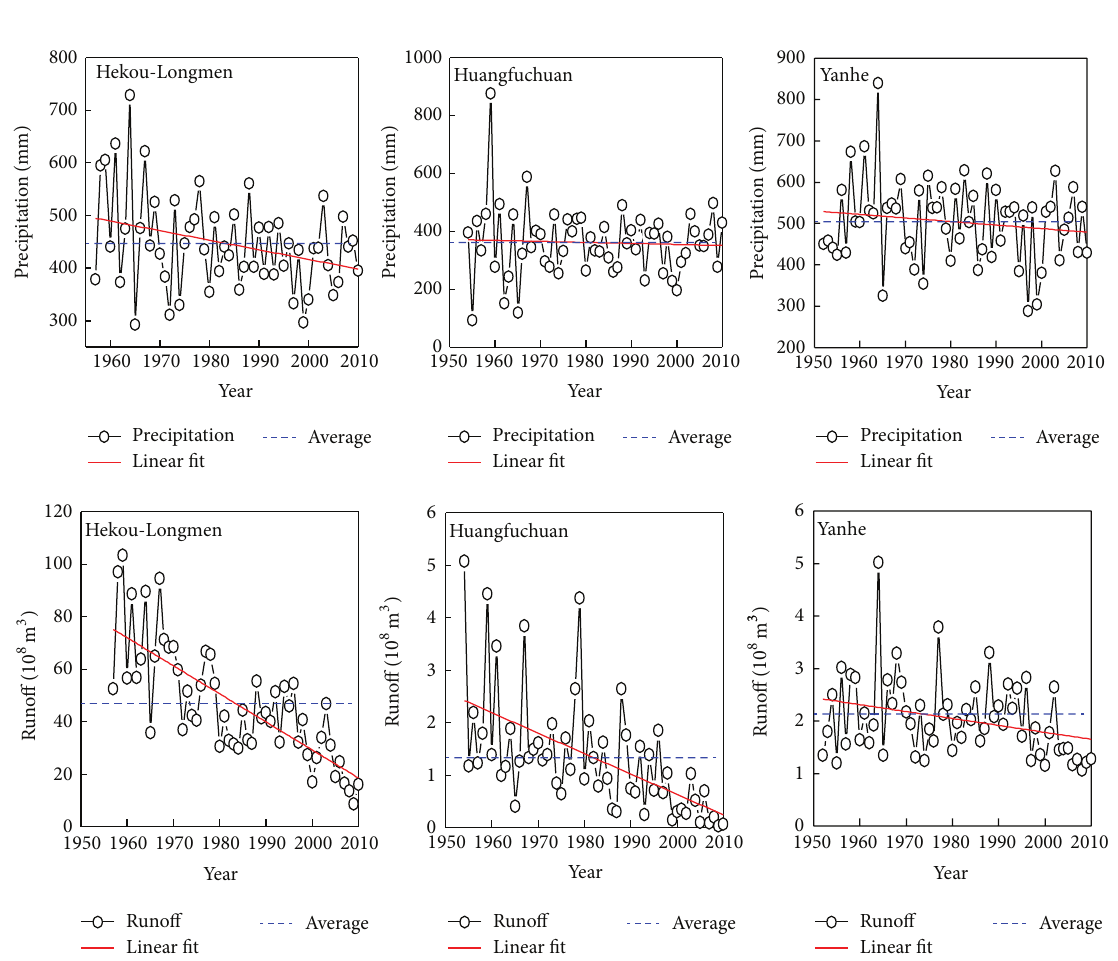
Figure 2: Temporal changes of precipitation and runoff in the Hekou-Longmen region, Huangfuchuan, and